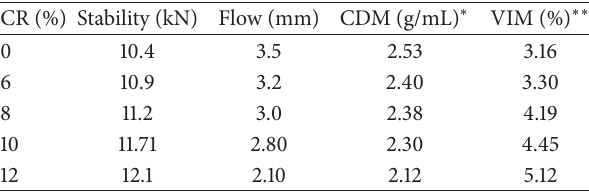
Table 7: Illustration of Marshall characteristics (ASTM D